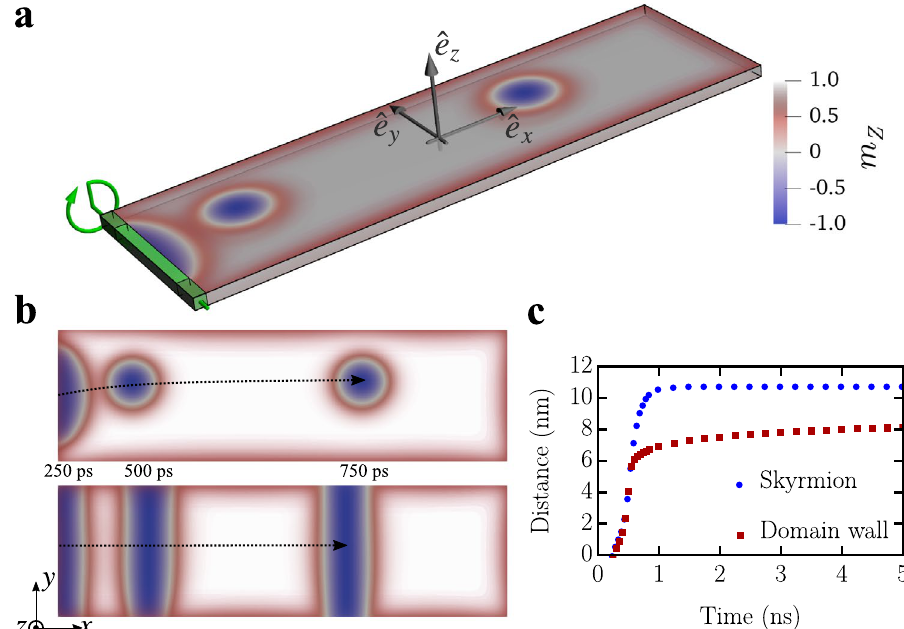
Figure 1. Skyrmion and domain wall creation in a magnetic stripe. ( a ) Schematics of the rotating effective magnetic field applied locally at the edge (green rectangular area) of the system. The time-dependent magnetic field rotates along the green arrow in the xz -plane with angle θ . ( b ) Real-space image of the motion of the skyrmion and DW for different time steps. For the skyrmion, the field is applied to two thirds of the width of the stripe (bright green area in ( a )), in the case of the DW, the full width is affected by the field. The shown positions correspond to 250 ps (half a rotation), 500 ps (full rotation), and 750 ps (half a period after turning off the time-dependent field). The Gilbert damping parameter is reduced to α = 0.01 in order to emphasize the differences in the motions. ( c ) Distance-time-diagram of a single created DW and skyrmion for a standard damping parameter α = 0.1 . System size: 100 × 30 × 1 c 3 with material parameters corresponding to Pd/Fe/ Ir(111); c = 0.233